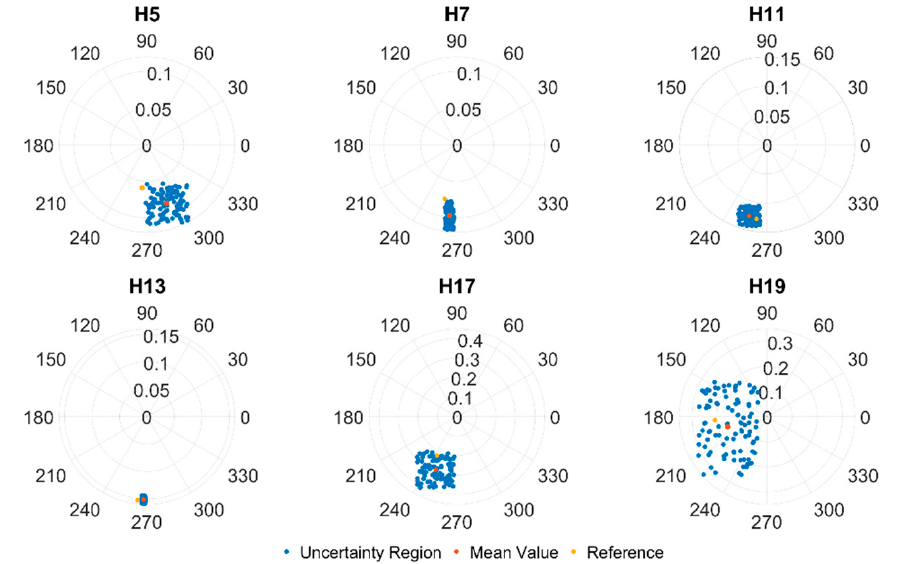
Figure 8. Compass plot of the customer side sub-grid impedance estimates (red dots) and the uncertainty region (blue dots) calculated using the VDC method. The reference impedance values are shown using yellow dots.